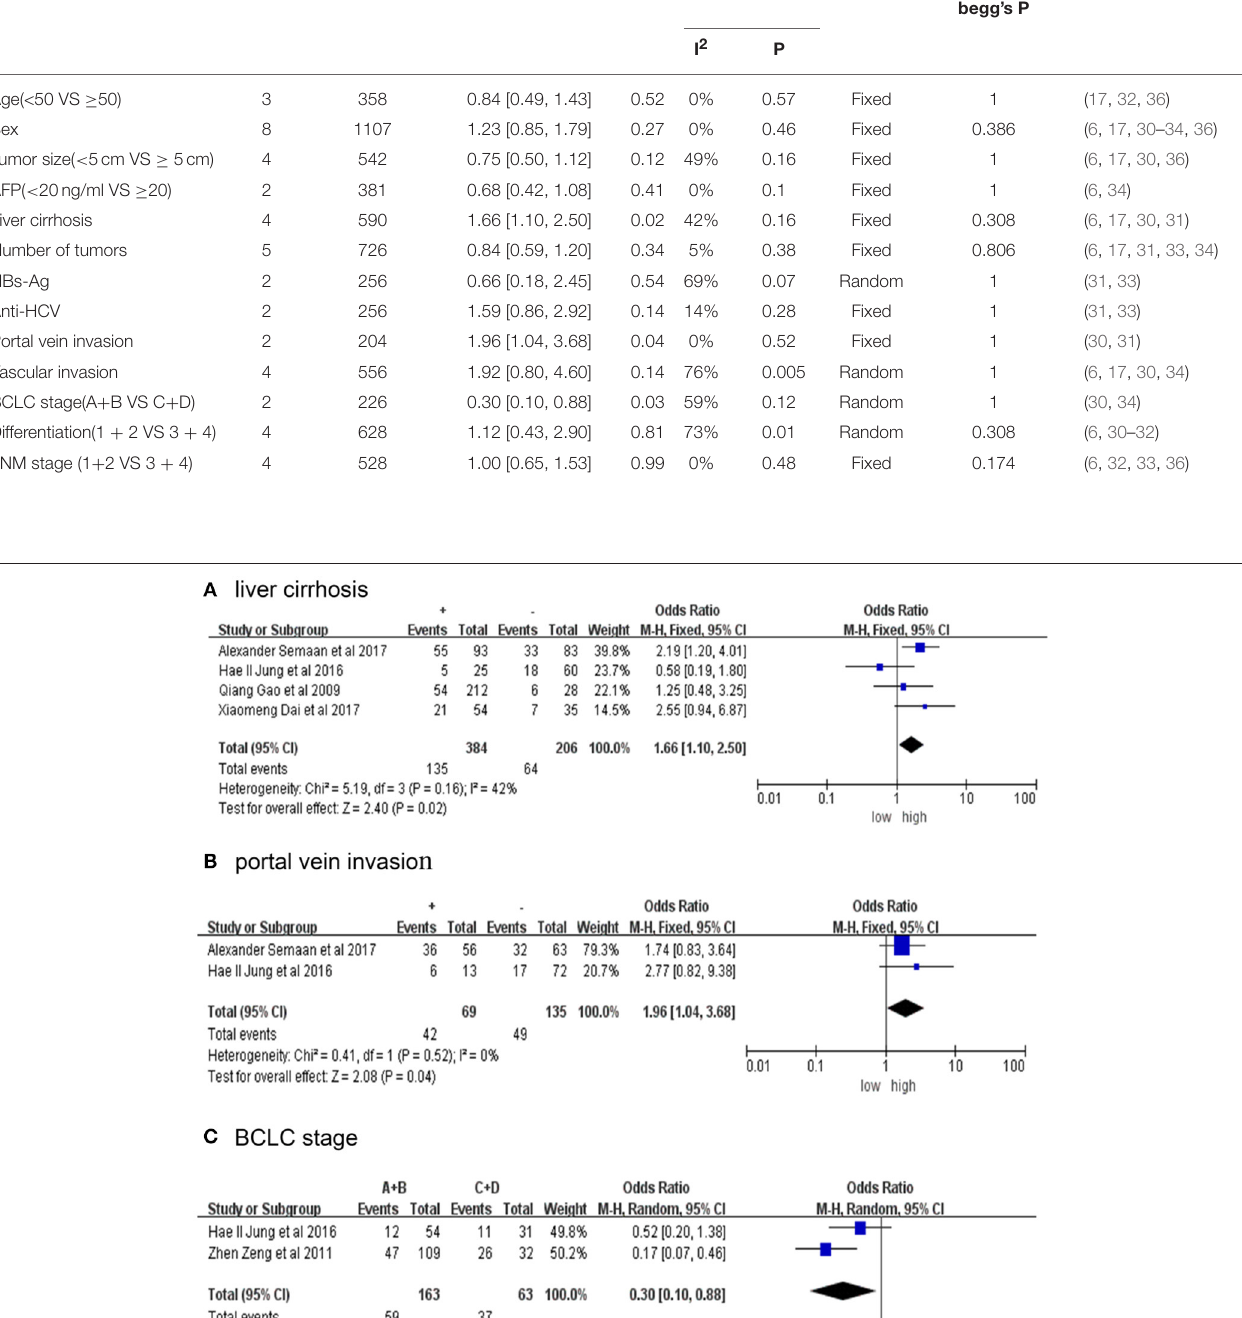
Frontiers in Immunology |